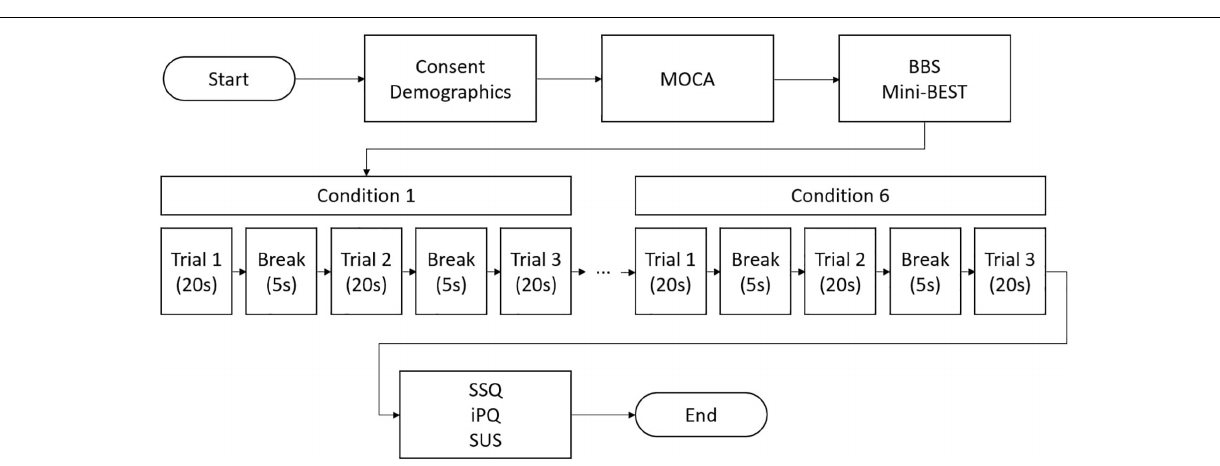
FIGURE 4 | A flow chart of VR-ComBAT experimental procedure (BBS = Berg Balance Scale; iPQ = igroup Presence Questionnaire; Mini-BEST = Mini Balance Evaluation Systems Test; MOCA = Montreal Cognitive Assessment; SSQ = Simulator Sickness Questionnaire; SUS = System Usability